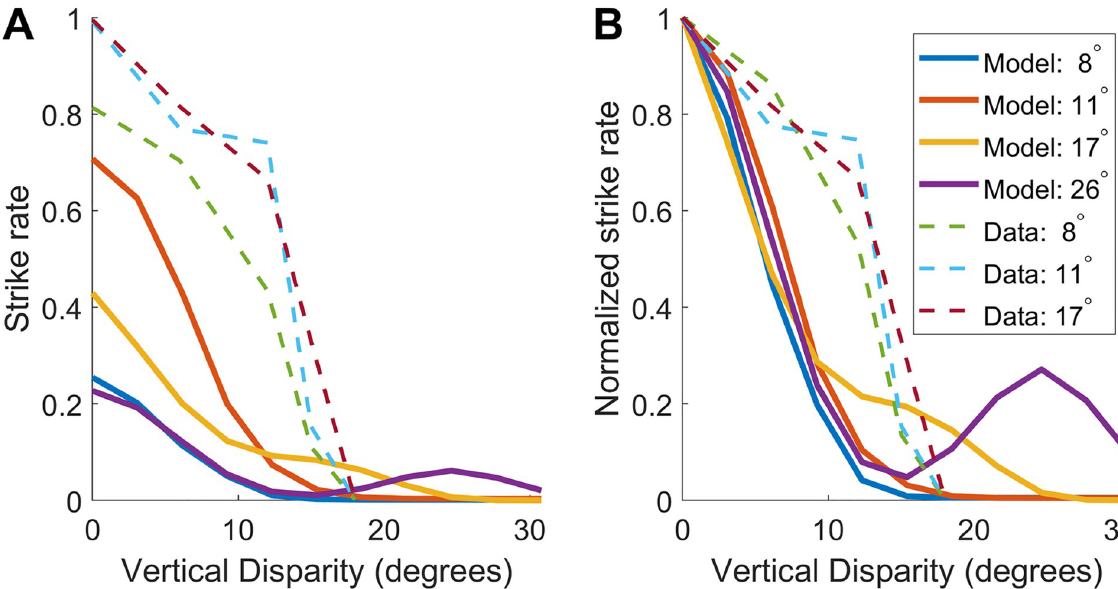
Fig 16. Sensitivity to vertical disparity and size, for our model (solid lines) and empirical data digitized from [31]. A: Solid lines show strike rate predicted by our model, averaged across horizontally and vertically travelling targets passing directly over the sensor. Dashed lines show strike rates observed by [31] for stationary “jiggling” targets. Colors indicate target size as shown in the legend. B: as A but the strike rate is normalized to be 1 for stimuli with zero vertical disparity.